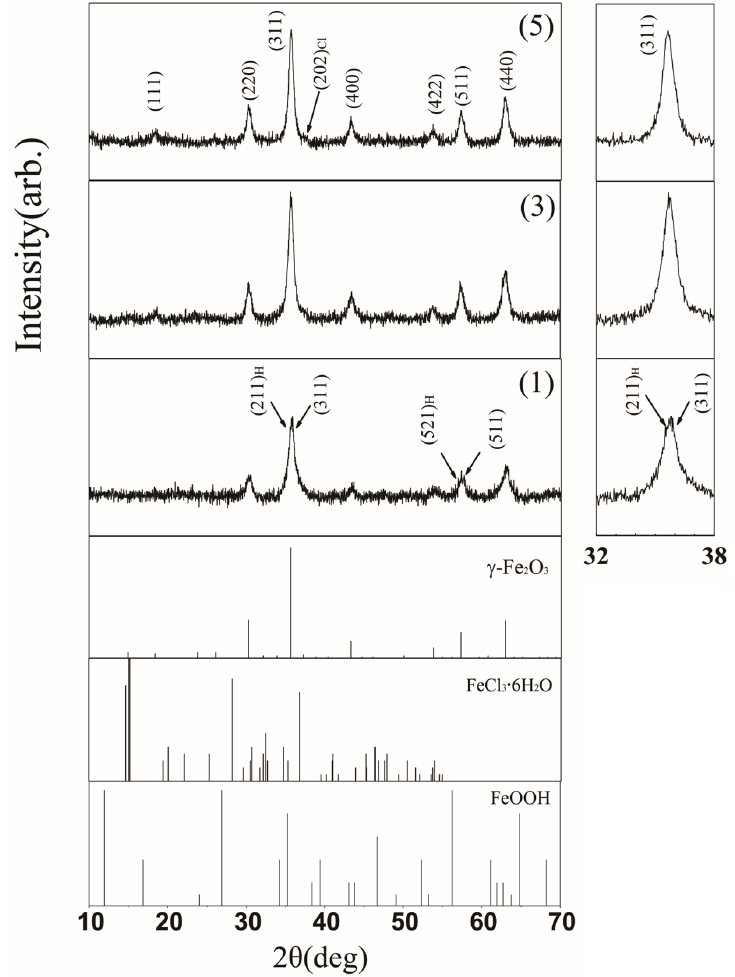
Figure 3. XRD spectra of samples (1), (3), and (5) with (hkl), (hkl) Cl and (hkl) Mg corresponding to γ -Fe 2 O 3 , FeCl 3 · 6H 2 O and FeOOH phases,